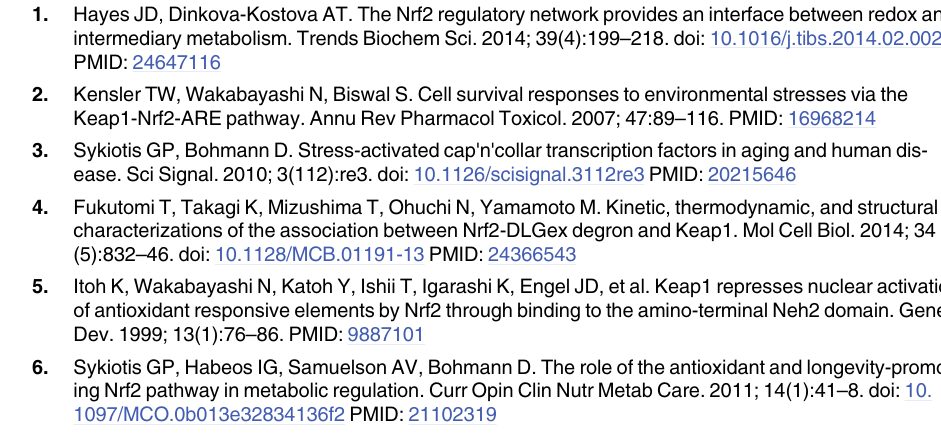
transfection; 90% of the lysates were used for IP with anti-Flag antibody and 10% of the lysates were used as input. The cell lysates and immuno-precipitates were analyzed by immuno-blot- ting (IB) with anti-Fs(1)h or anti-Flag antibodies as indicated. Arrows indicate the position of bands corresponding to Flag-CncA, B, C, Fs(1)h-S and Fs(1)h-L, respectively. S5 Fig. BET proteins regulate Nrf2 activity independently of Keap1. (A) Combination of Fs (1)h knock down with either Keap1 knock down or CncC over-expression under Actin-Gal4 driver causes synergistic activation of ARE-Fluc reporter in S2 cells. Over-expression of Keap1, on the other hand, suppresses induction of ARE in response to Fs(1)h knock down. (B) Combi- nation of BET protein inhibitor JQ1(0.5 μ M) but not Keap1 inhibitor sulforaphane (10 μ M) with transient Nrf2 over-expression from a CMV-driven expression vector causes synergistic activation of NQO1-fluc reporter in HEK293 cells. S1 Document. Variability in oxidative stress responsiveness among biological replicates. The stress sensitivity experiments were carried out with 4 biological replicates (separate vials, each with 20 flies). The error bars represent standard deviations in percent survival among bio- logical